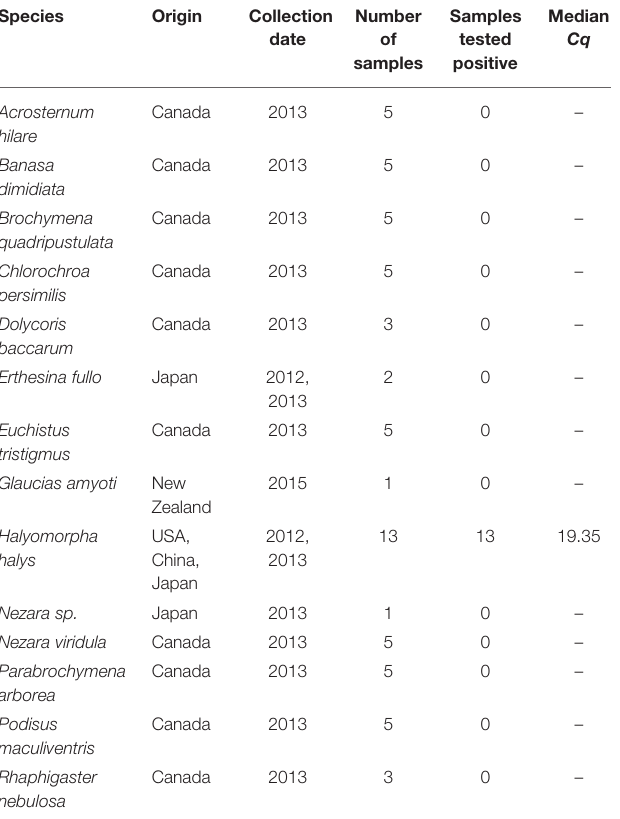
TABLE 1 | Samples used for specificity testing of the BMSB assay. Species Origin Number